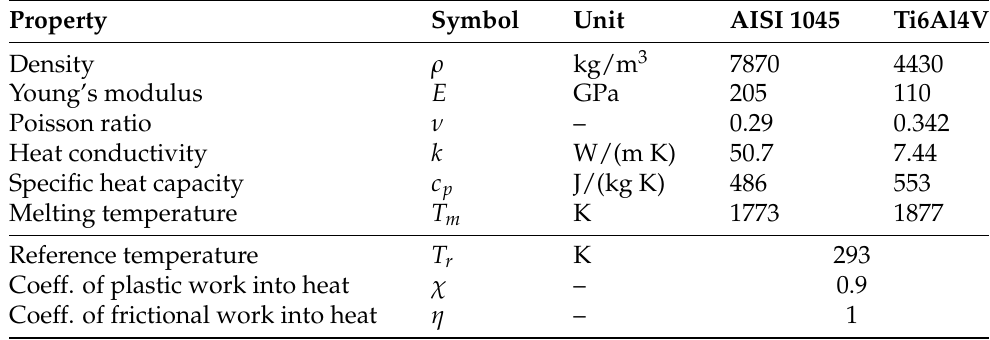
Table 8. Material properties of AISI 1045 and Ti6Al4V used for